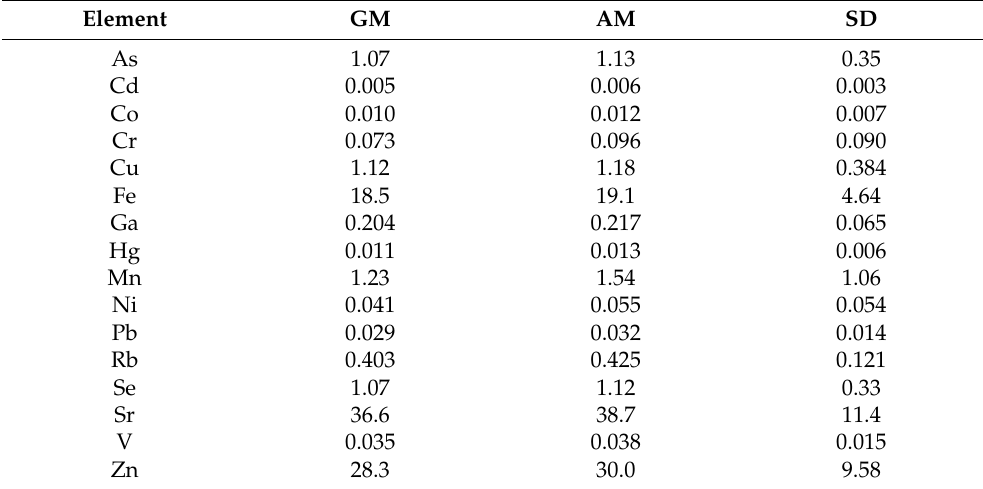
Table 2. Statistical values (GM, AM, SD) of trace element concentrations found in the egg samples of loggerhead sea turtles expressed in mg kg − 1